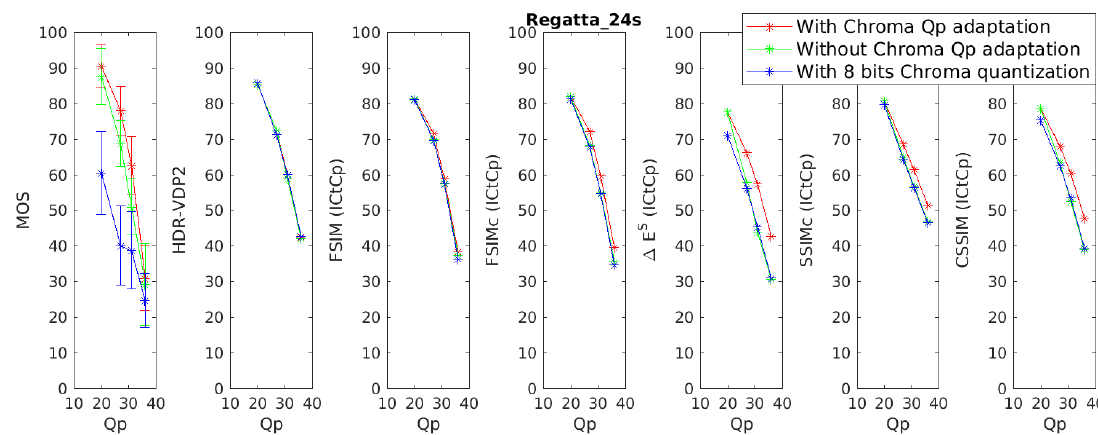
Figure A11. Subjective and objective scores for the image